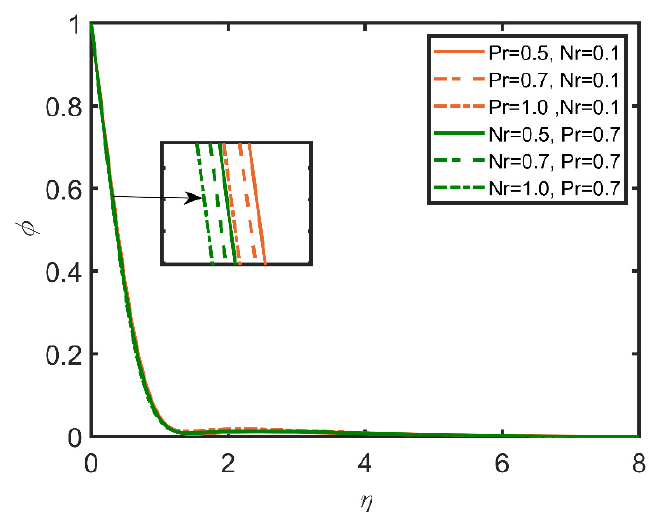
Figure 12. Comparison for concentration profile against 𝜂 .